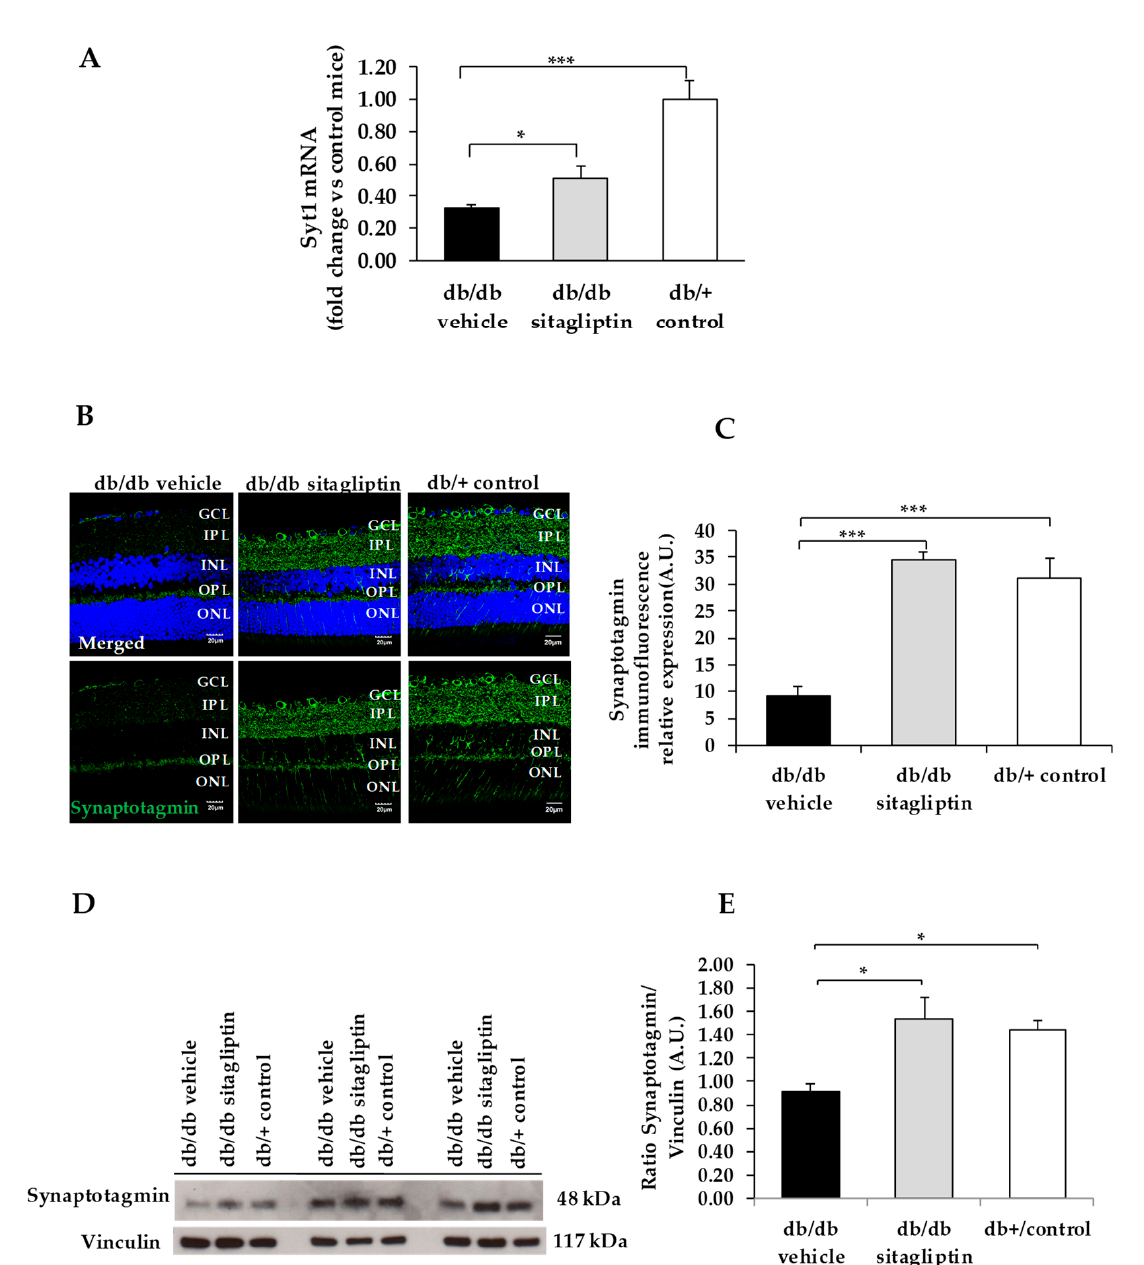
Figure 3. ( A ) Real-time quantitative RT-PCR analysis of synaptotagmin gene (Syt1) in db/db mice treated with vehicle (black bars), sitagliptin eye drops (grey bars), and in non-diabetic mice (white bars). ( B ) Immunofluorescence of synaptotagmin (green) among representative samples of diabetic retinas of experimental groups. Hoechst staining (blue) was used for nuclei labeling. ONL: outer nuclear layer; OPL: outer plexifom layer; INL: inner nuclear layer; IPL: inner plexiform layer; GCL: ganglion cell layer. Scale bars, 20 µ m. ( C ) Quantification of synaptotagmin immunofluoresence in diabetic mice treated with vehicle eye drops (black bars), sitagliptin eye drops (grey bars), and in non-diabetic retinas (white bars). ( D ) Western blot bands of synaptotagmin, and ( E ) Densitometric analysis in db/db mice treated with vehicle eye drops (black bars), sitagliptin eye drops (grey bars), and in non-diabetic mice retinas (white bars). Protein levels were normalized with vinculin. * p < 0.05, *** p < 0.001.